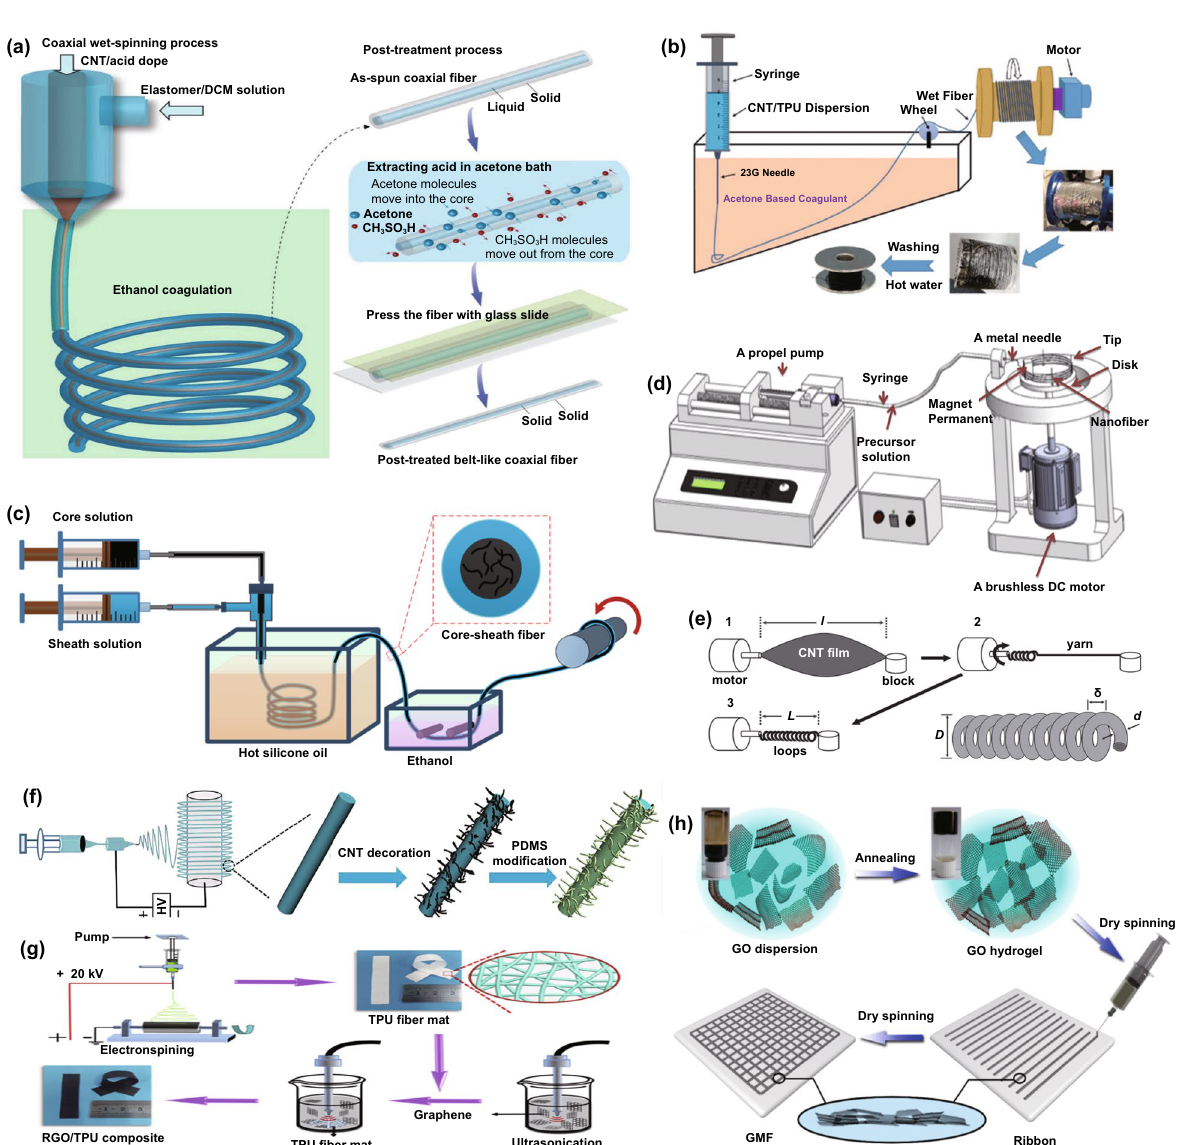
Fig. 1 a Wet-spinning and post-treatment process for the fabrication of thermoplastic elastomer and CNT composted fibers [96]. Copyright © 2018 Wiley–VCH. b The production of thermoplastic polyurethane/CNT fibers for strain sensing via wet-spinning [97]. Copyright © 2019 Royal Society of Chemistry. c Wet-spinning process for the fabrication of Ecoflex-30 and CNT composited fibers [98]. Copyright © 2018 American Chemical Society. d Schematic diagram of magnetic-mechanical spinning [102]. Copyright © 2017 Elsevier . e Schematic diagram of fabrication of spring-like CNT rope from CNT film by spinning technique [103]. Copyright © 2012 Wiley–VCH. f Electrospinning TPU fibers modified with CNT and PDMS[104]. Copyright © 2019 Elsevier. g Electrospinning TPU fibers modified with graphene for strain sensing [76]. Copy- right © 2016 Elsevier. h The fabrication of graphene oxide ribbons and mesh fabrics through the dry spinning process [107]. Copyright © 2015 American Chemical